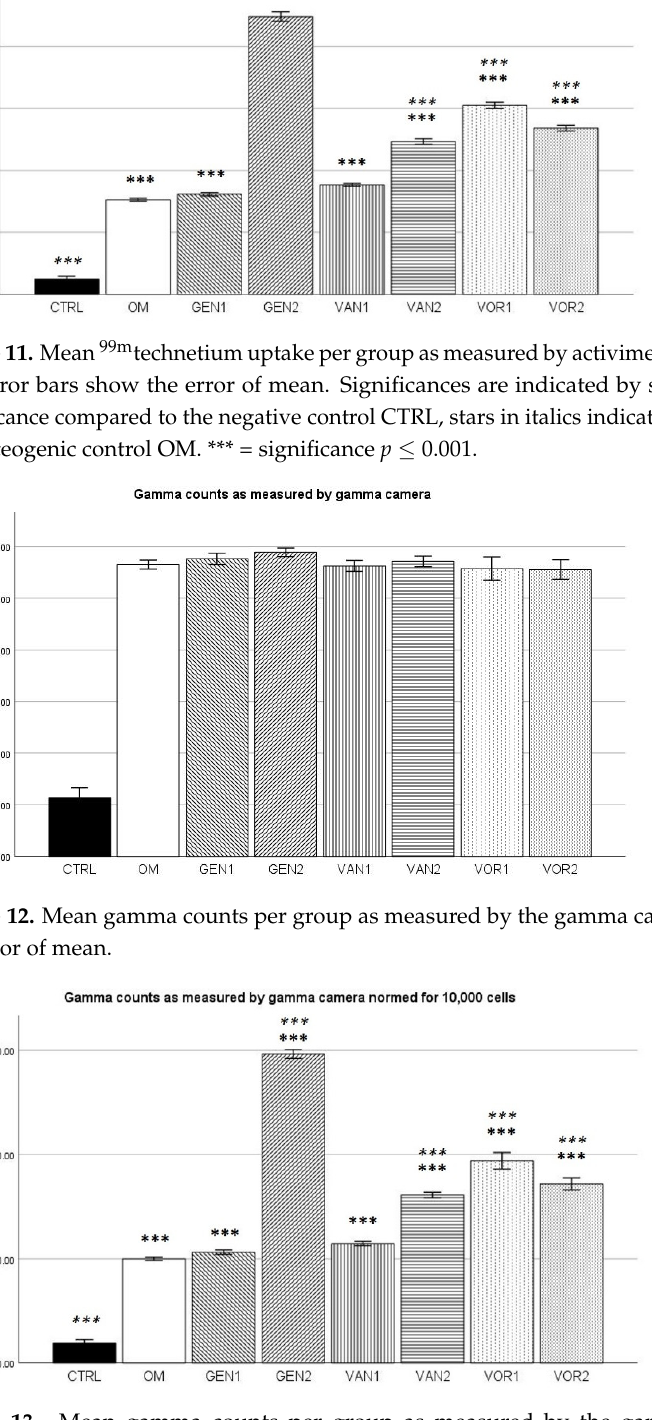
Figure 13. Mean gamma counts per group as measured by the gamma camera, normed for 10,000 cells. The error bars show the error of mean. Significances are indicated by stars: bold stars indicate a significance compared to the negative control CTRL, stars in italics indicate a significance compare to the osteogenic control OM. *** = significance p ≤ 0.001.